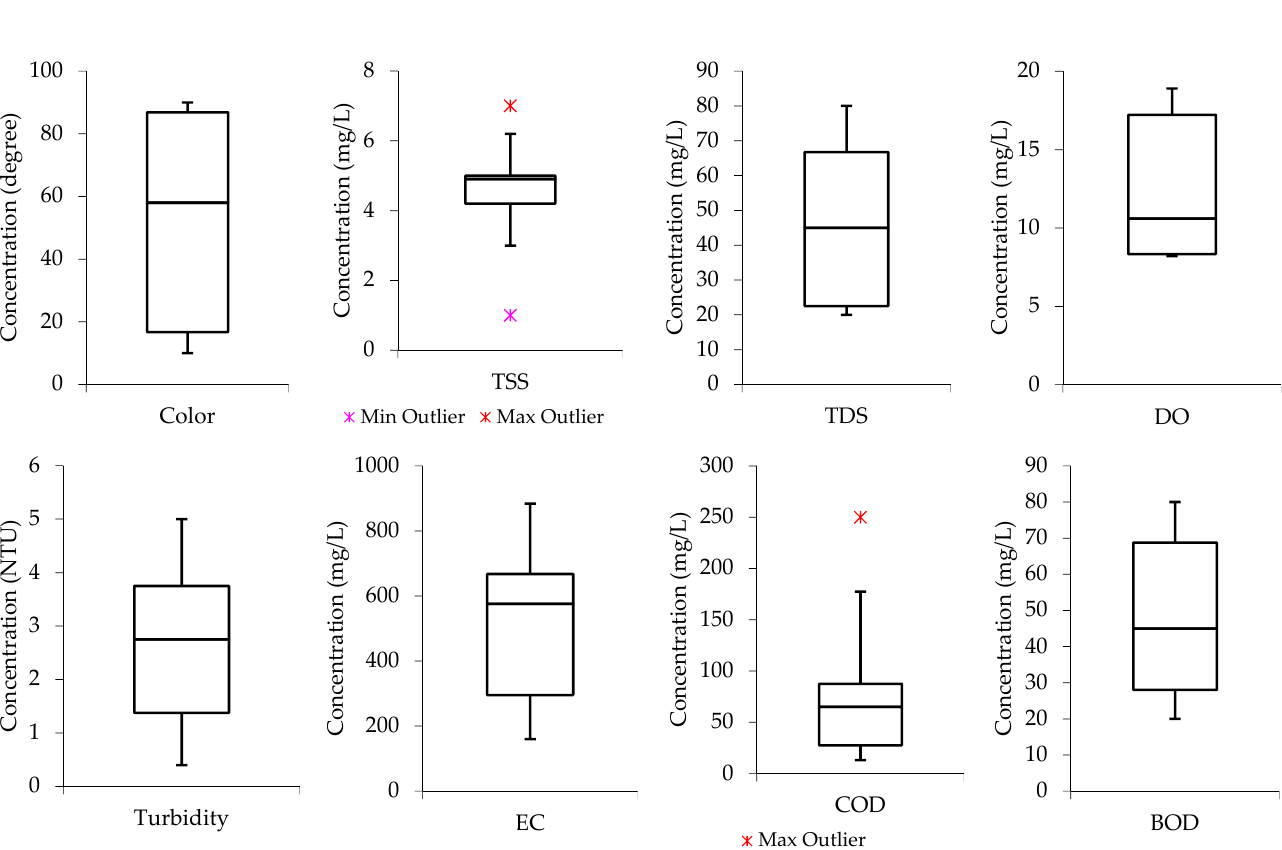
Figure 2. Data distribution from the 1 m column samples for color, TSS, TDS, DO, turbidity, EC, COD, and BOD.